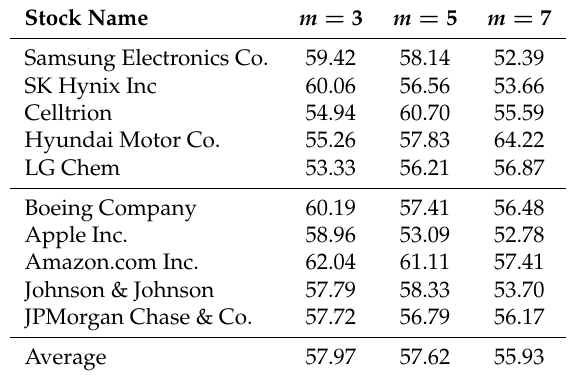
Table 7. Average accuracy for different numbers of similar-field stocks over all study